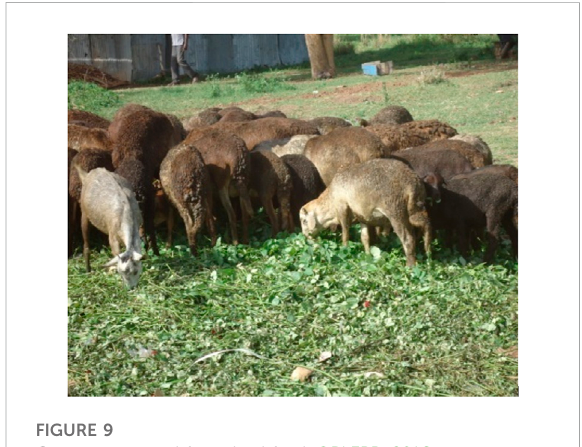
FIGURE 9 Green waste used for animal feed. ORLEPB,